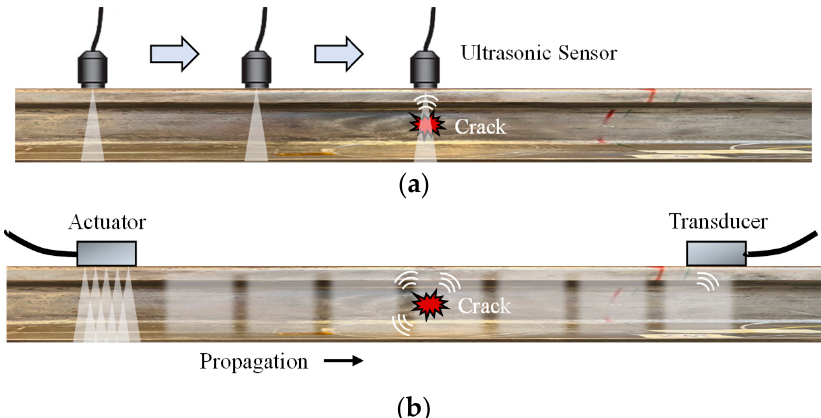
Figure 3. Comparison of: ( a ) bulk wave inspection; versus ( b ) guided wave inspection.